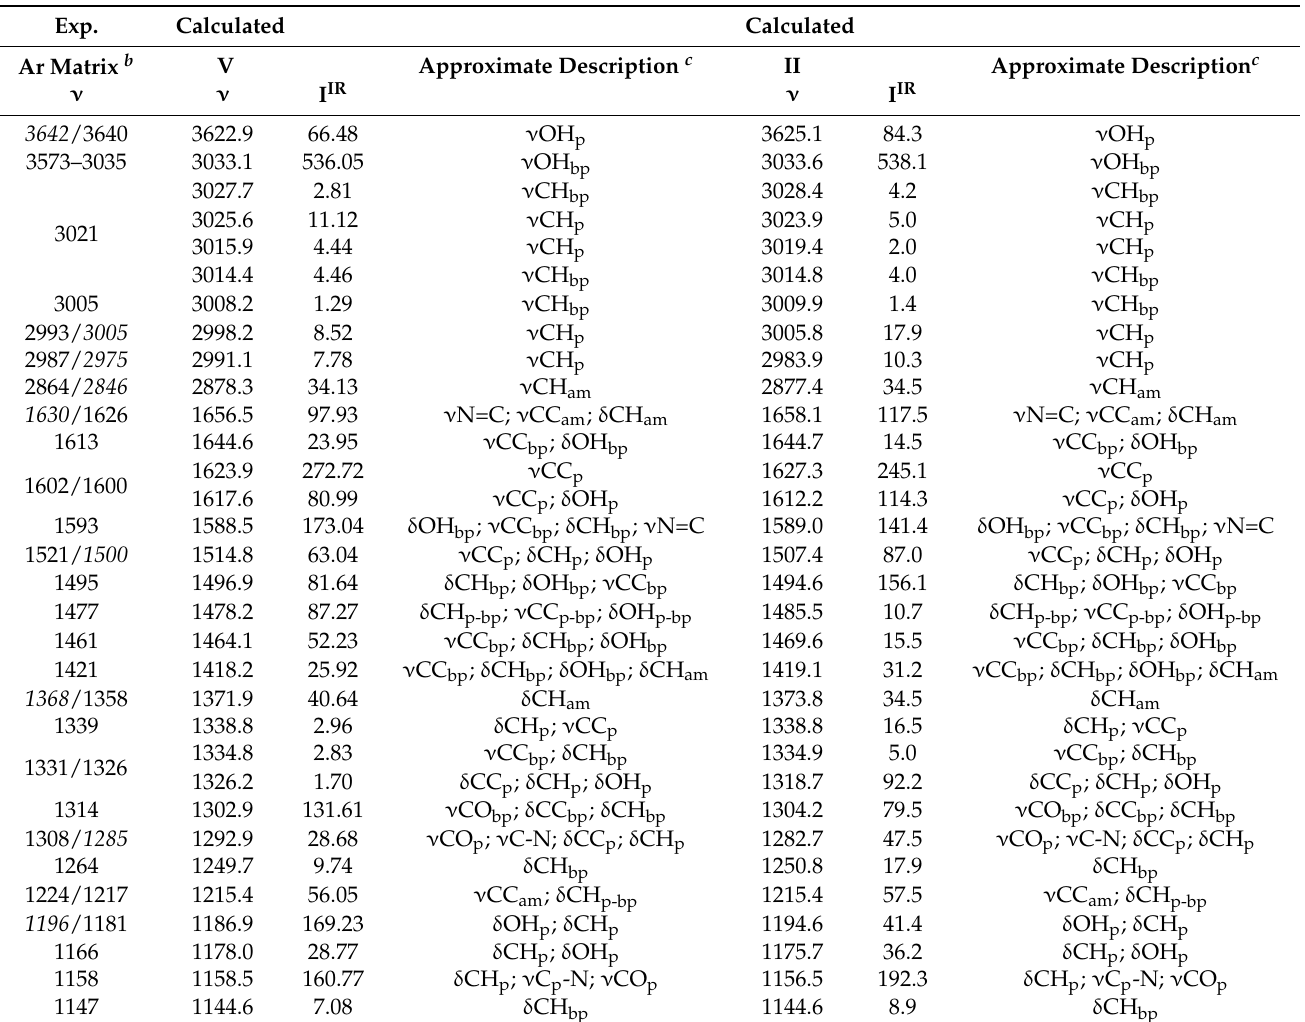
Table 8. Assignment of the vibrational spectra of BHAP isolated in an argon matrix (10 K), and the B3LYP/6-311++G(d,p) calculated spectra for E -enol-imine conformers V and II a .